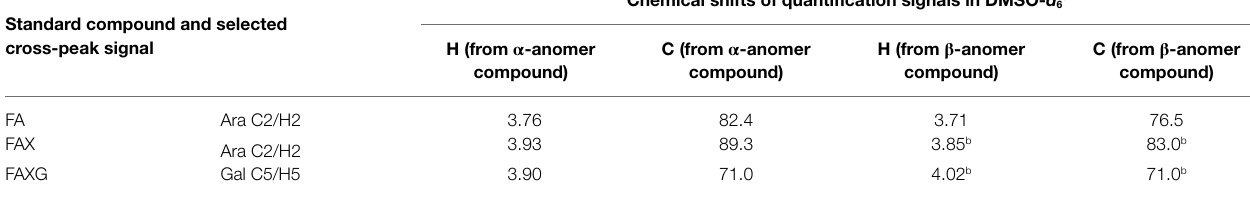
TABLE 1 | HSQC cross-peak signals selected for